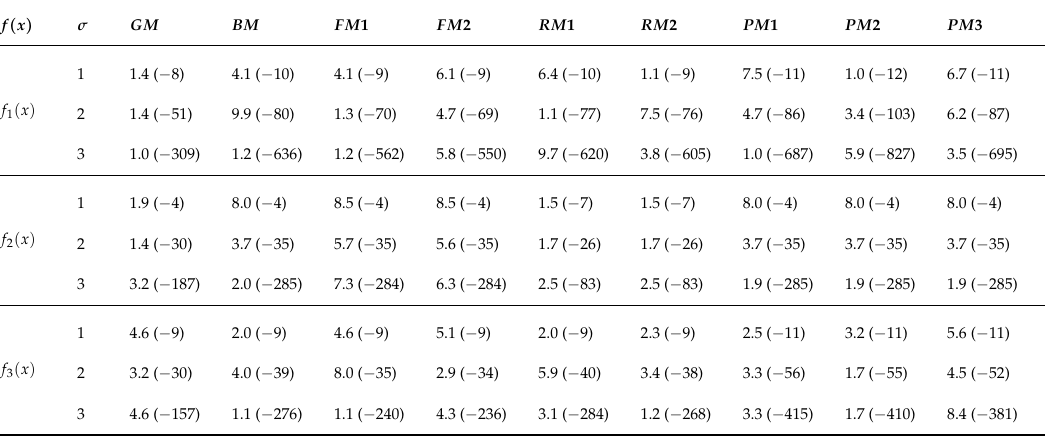
Table 3. Contrast on the ground of residual errors (i.e., | f ( x σ ) |